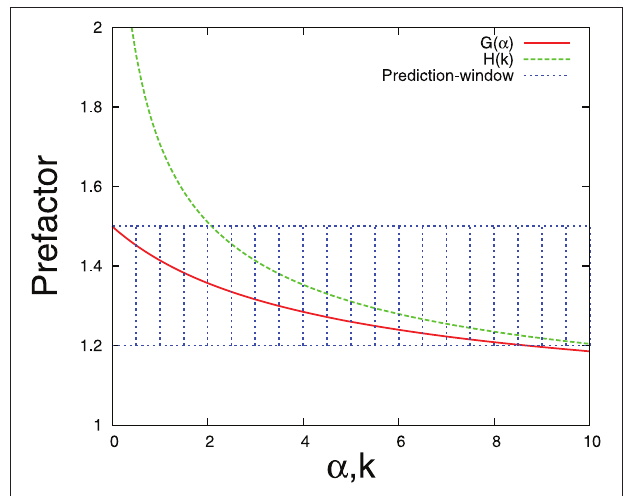
FIGURE 9 | The prefactor (Equations 54, 55) vs. α , k values of the fiber threshold distributions and the suggested